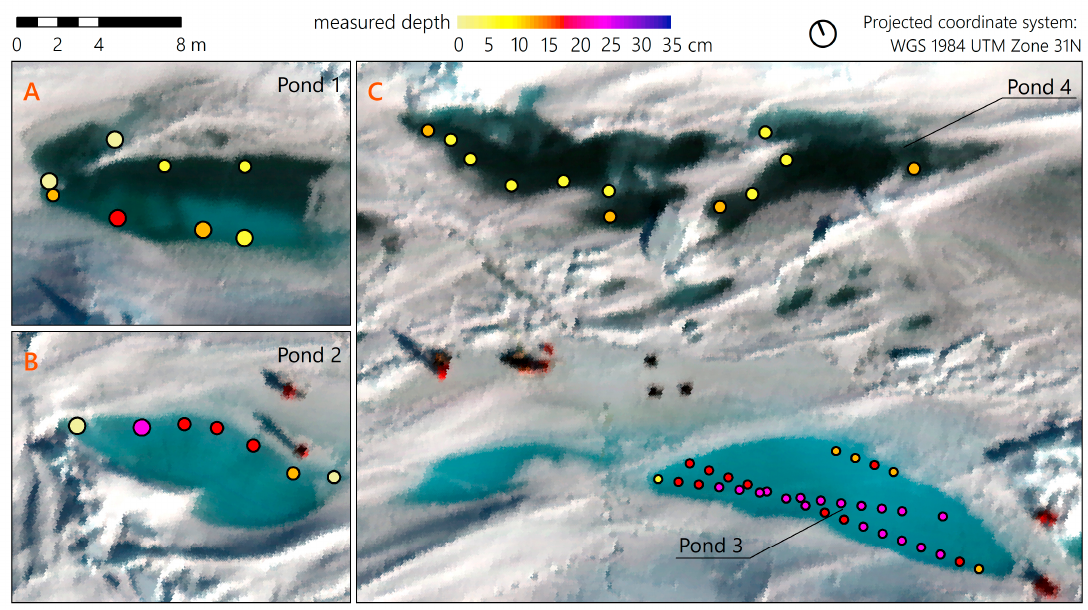
Figure 2. In situ depth measurement locations. Circle sizes correspond to estimated spatial uncertainties (radii are 20 cm, 30 cm and 40 cm). ( A ) Pond 1. ( B ) Pond 2. ( C ) Ponds 3 and 4. Background: AisaEAGLE flight stripe (spatial resolution: 8.5 cm, RGB: 661.16 nm, 550.25 nm, and 482.57 nm).